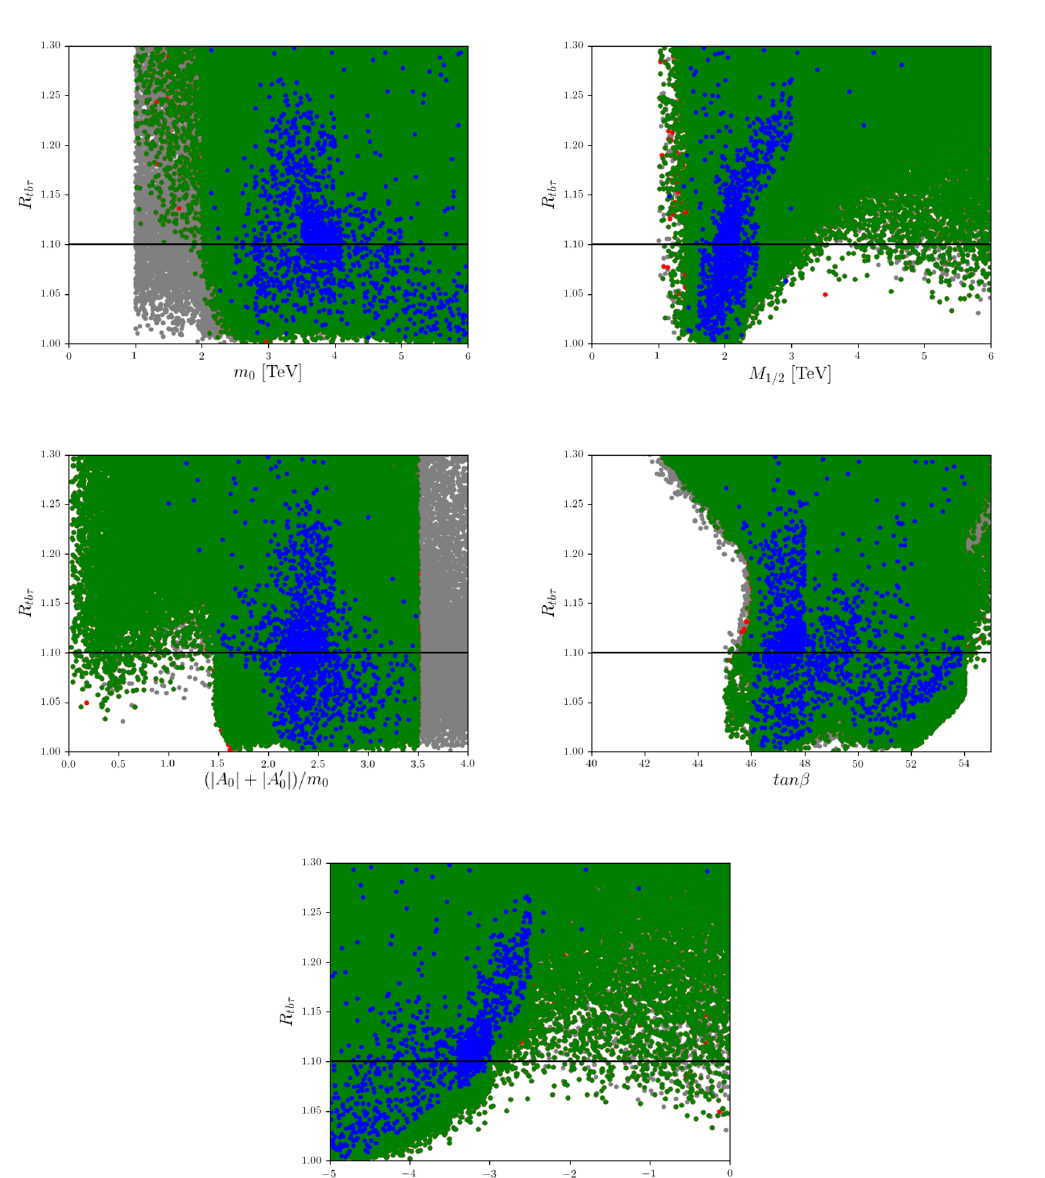
Figure 2 . The fundamental parameter space versus t − b − τ YU ( R tbτ ) over the following planes: m 0 − R tbτ (top left), M − R tbτ (top right), ( | A 0 | + | A 0 | 2 ) /m 0 − R tbτ (middle left), tanβ − R tbτ 1 / 2 0 (middle right) and µ 0 − R (bottom). Our colour convention is as listed at the end of section 3. tbτ The solid line indicates the region consistent with YU with R 1 . 1 tbτ ≤